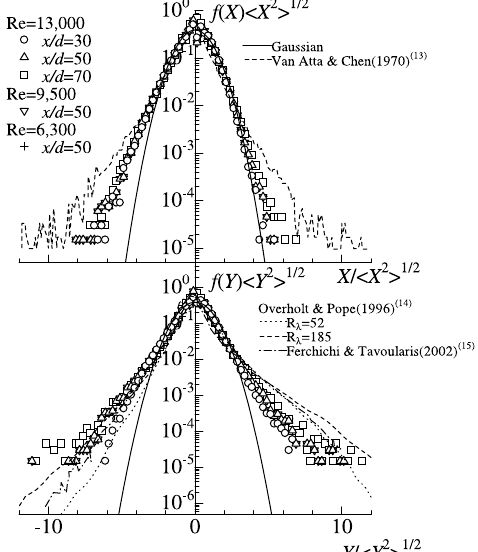
Fig. 6 Distributions of PDFs for streamwise velocity derivative and concentration derivative, where X = ∂ u /∂ x and Y = ∂ c /∂